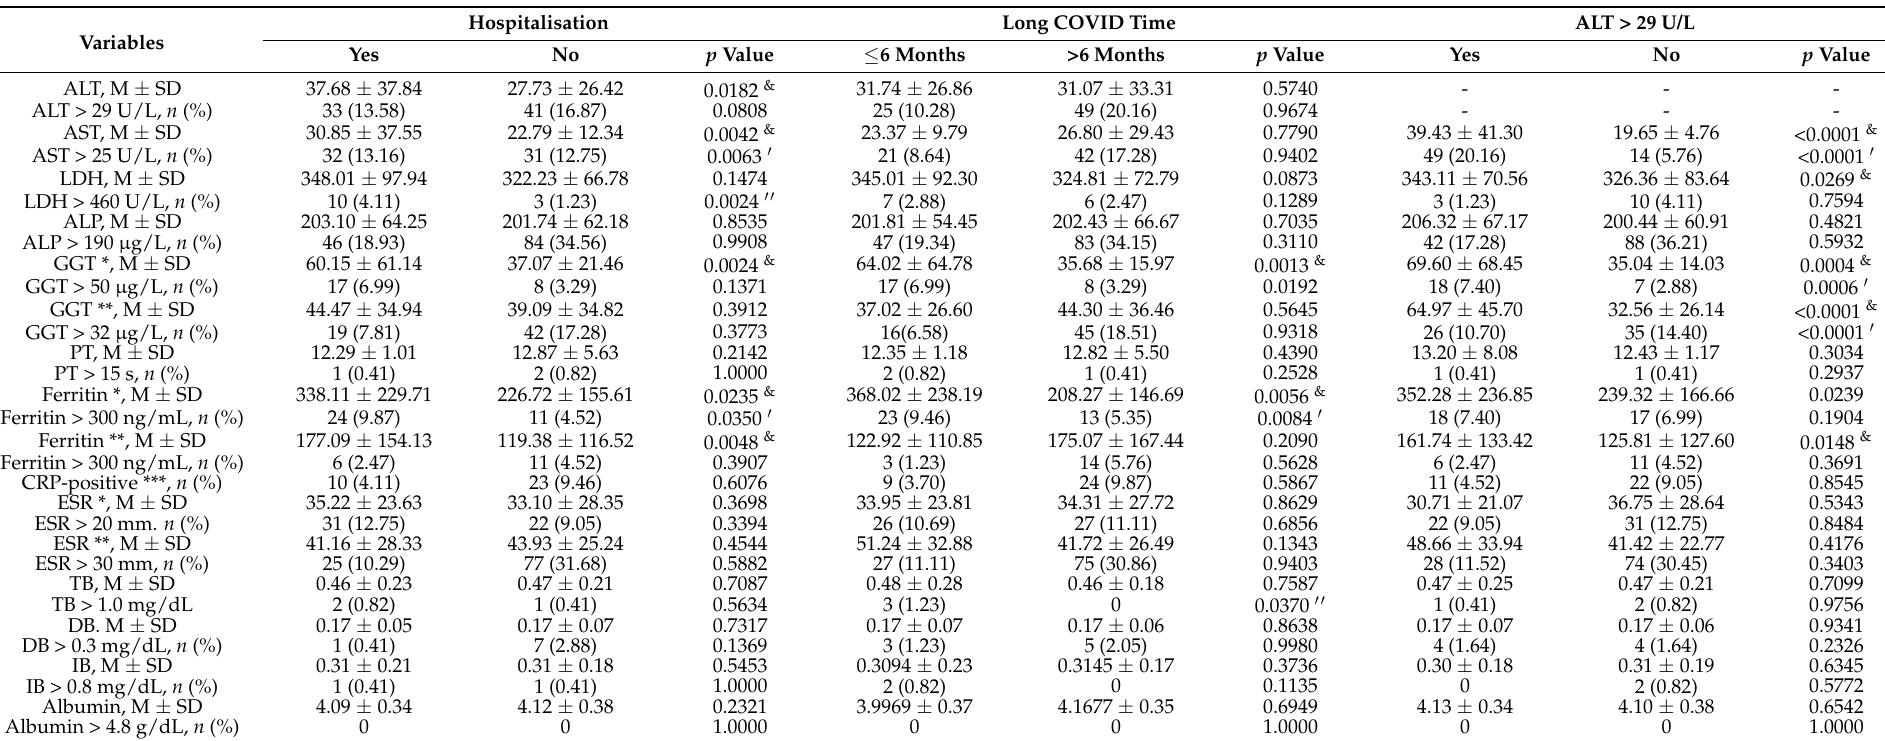
Table 2. Comparison of liver function laboratory variables between hospitalisation groups, post-COVID time, and ALT > 29 U/L. Bel é m/PA,